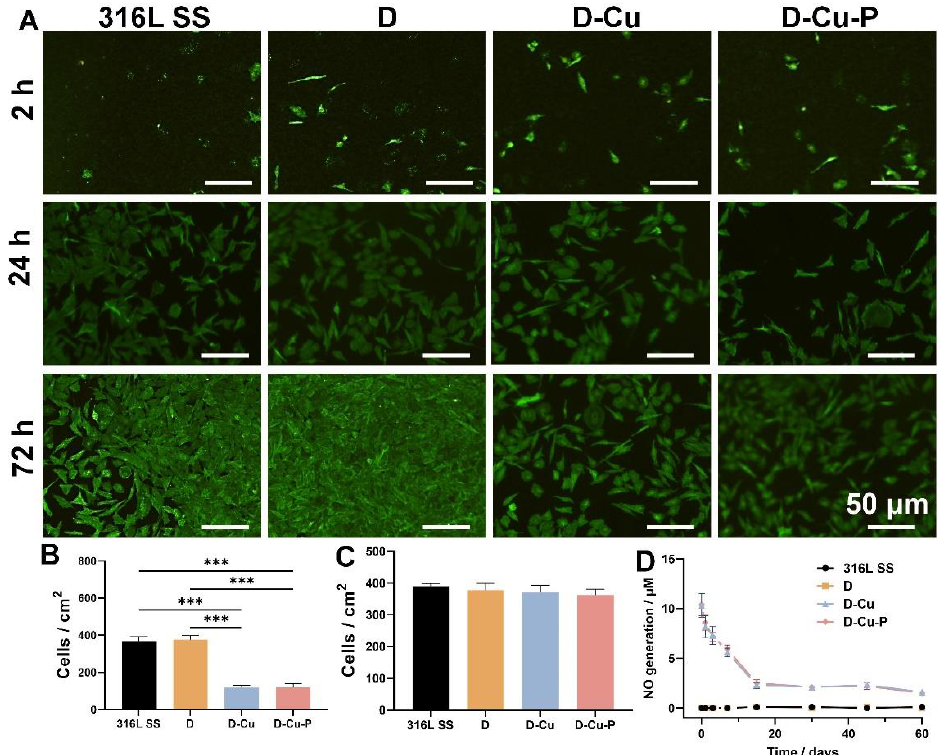
Figure 5. Catalyzed NO generation and SMCs inhibition evaluations. ( A ) Live/dead staining of the SMCs after 2, 24, and 72 h. ( B ) Cell adhesion rate, ( C ) viability, and ( D ) proliferation rate of the samples. *** p < 0.001 denote the statistical